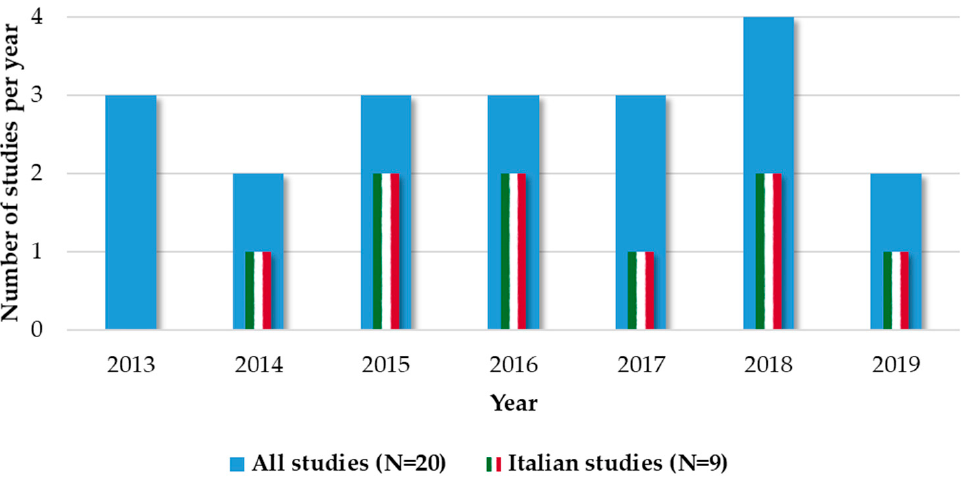
Figure 3. Distribution of studies on wine WF assessment by year.